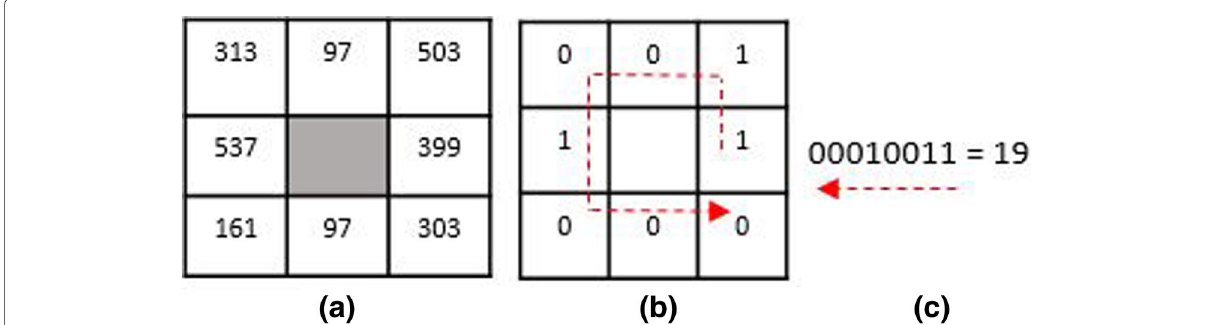
Fig. 12 Process of encoding an image with LDP operator k = 3 a Result of convolving image region with masks in Figure 11. b Setting bit values of k significant values to 1 and the rest to 0. c Resultant binary string and its decimal